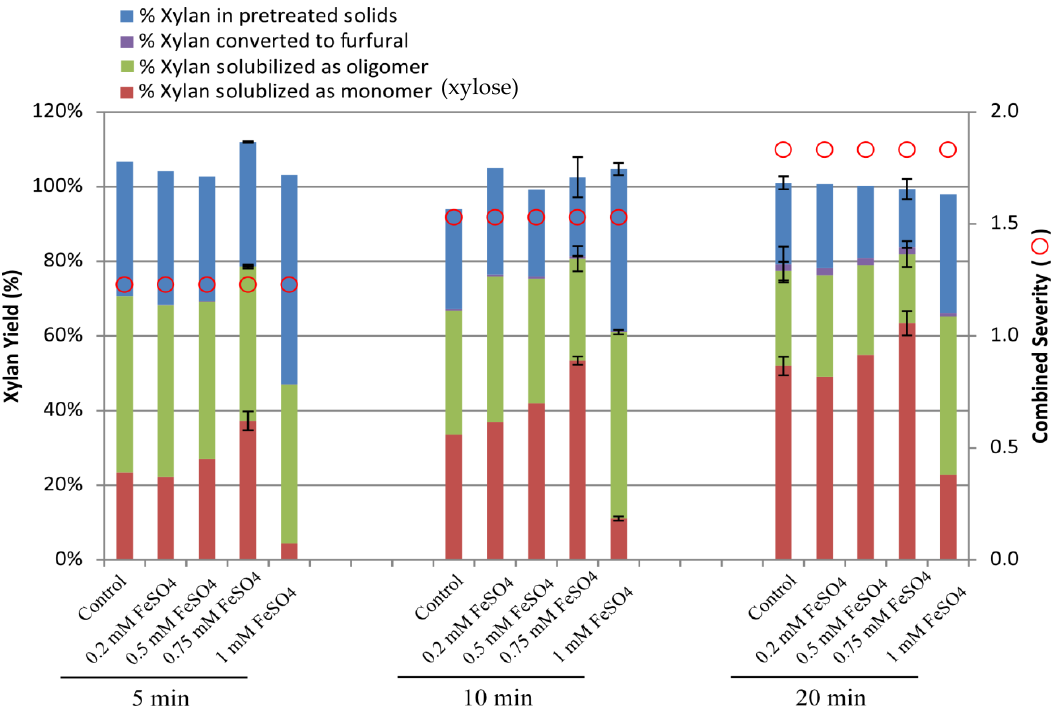
Figure 1. Xylan/xylose mass balance closure for pretreatments at 150 °C and 0.5% H 2 SO 4 with increasing levels of FeSO 4 addition.